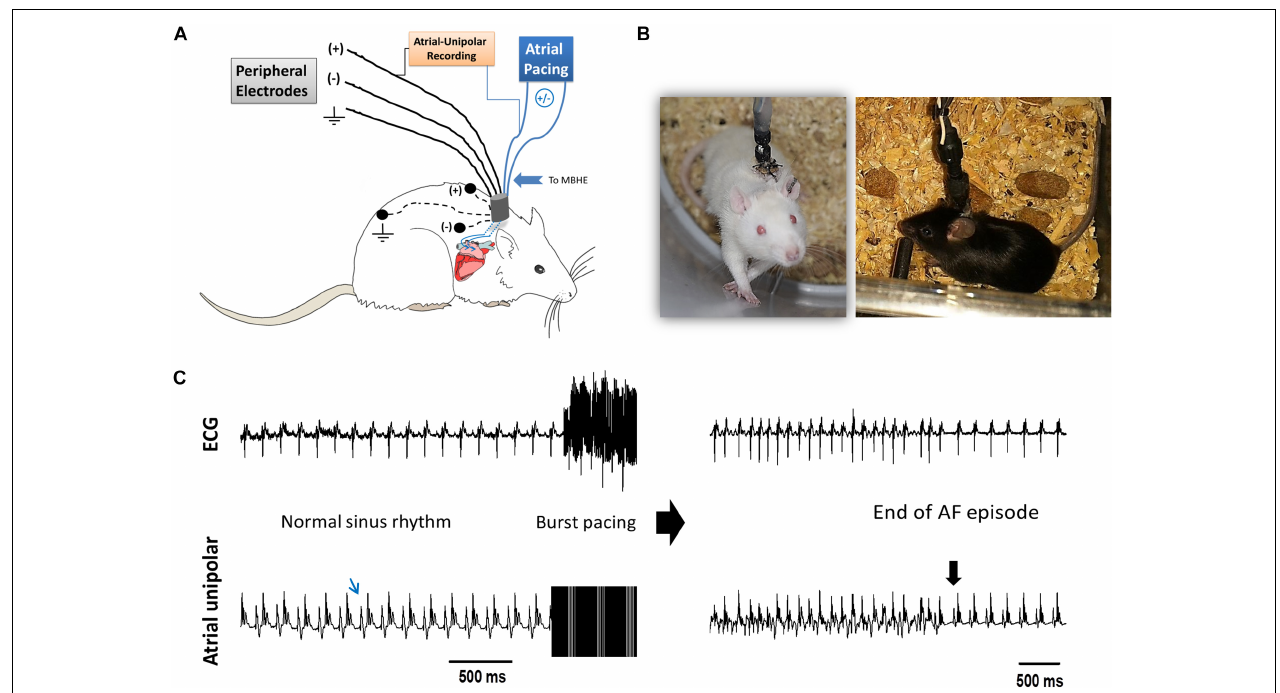
FIGURE 1 | AF substrate analysis in unanesthetized rodents. (A) Schematic presentation of the experimental setup. MBHE was implanted on the RA for atrial pacing. One pole of the atrial electrode was also utilized to acquire high resolution recordings of the atrial signal (Atrial-Unipolar). (B) Photographs of an implanted rat and an implanted mouse freely moving in the EP cage during the RAP protocol. (C) Example of an AF episode triggered by burst pacing. This episode of 82 s was recorded from a rat that was exposed to RAP for 7 consecutive days (see Figure 2 for details). Left: Baseline ECG and atrial-unipolar recordings. Middle: Standard burst pacing protocol (20 s, 100 Hz, double threshold). Right: Post-burst recordings of an AF episode and its conversion to sinus rhythm. In each condition, 10 consecutive bursts were applied. AF substrate was evaluated in regard to the % of positive episodes ( > 1 s) and the total AF